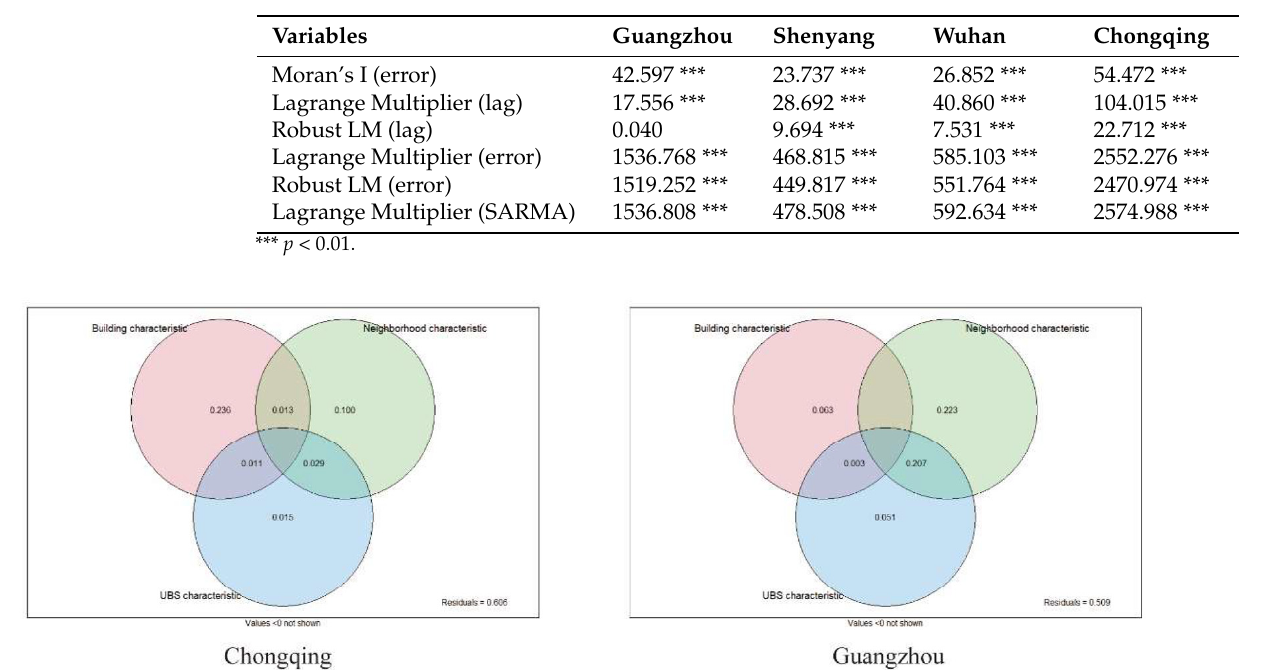
Table A14. LM tests for Model II.